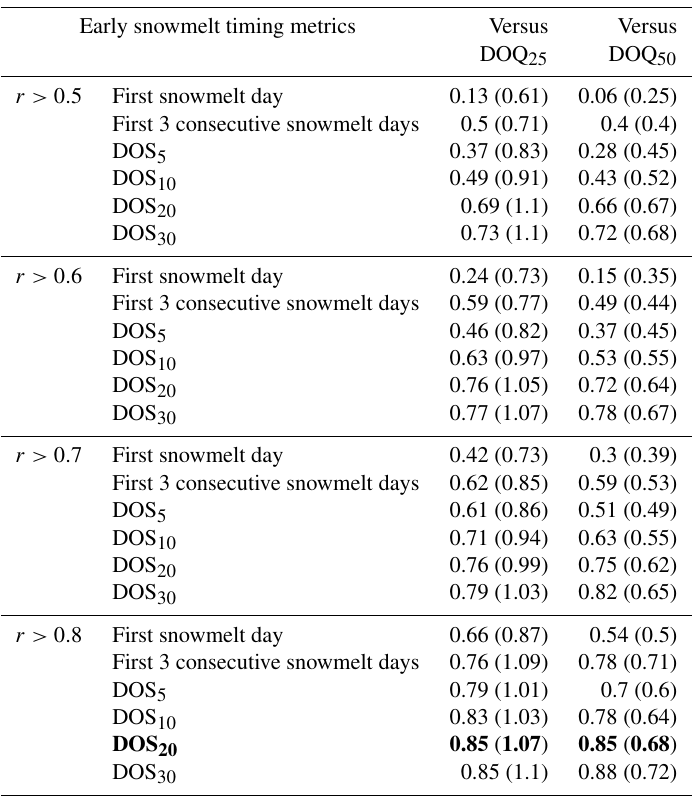
Table A1. Coefficient of determination ( R 2 ) and slope (in parentheses; day/day) of the linear regression between different early snowmelt timing metrics and DOQ 25 and DOQ 50 , as presented in Fig. 5, for different correlation cutoffs ( r ) between hourly solar radiation and streamflow. DOS xx represent the date when the xx th percentile of snowmelt days occurs. Site ID 24, 35, and 31 are excluded from the linear relationship. Bolded numbers are those used in the result and discussion sections.